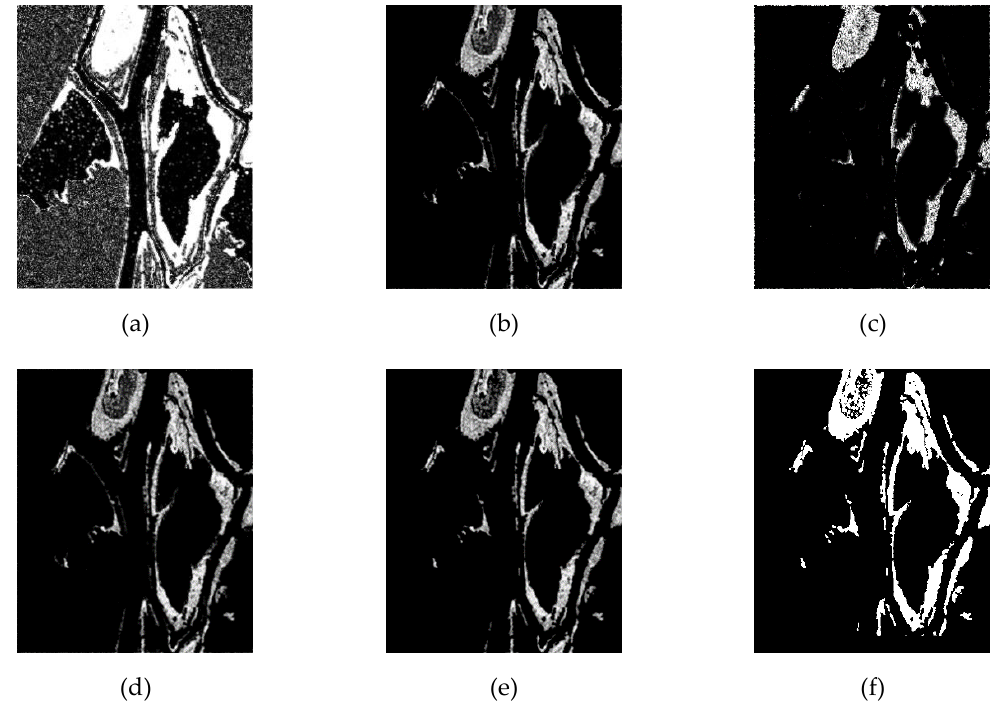
Figure 4. Test results in Ottawa area. ( a ) the low-frequency difference image based on the logarithmic variation function, ( b ) the low-frequency difference coefficient image after further clustering, ( c ) the high-frequency difference coefficient image after similarity analysis, ( d ) the NSCT inverse transform fusion image, ( e ) the clustering result image, and ( f ) the last change detection binary image.